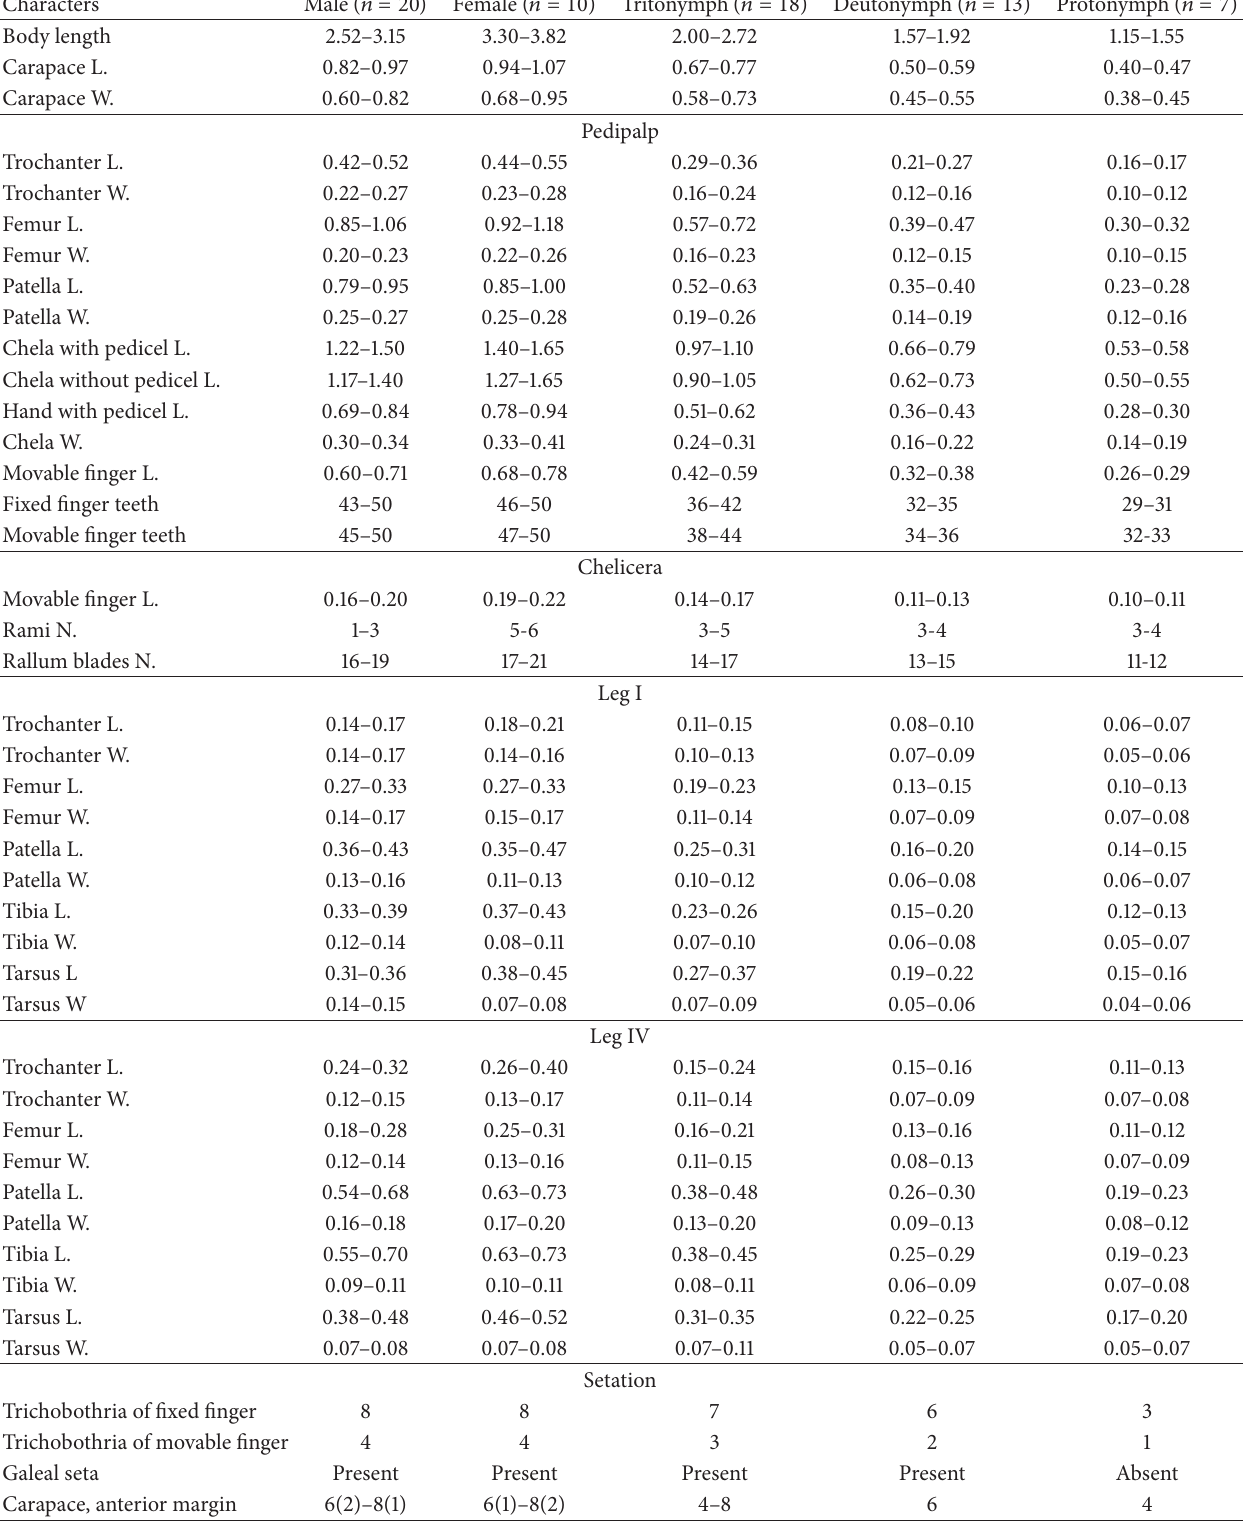
Table 1: Morphological measurements (mm), numbers, and setation in Dactylochelifer gracilis